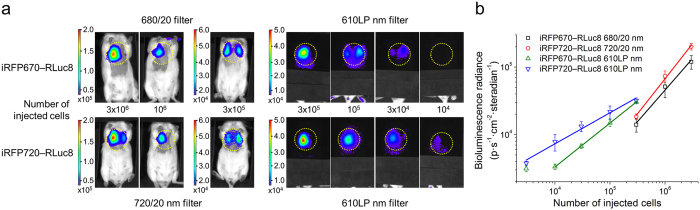
Deep-tissue BLI with NIR chimeric luciferases.(a) Imaging of MTLn3 cells stably expressing iRFP670—RLuc8 or iRFP720—RLuc8 injected in CFW mice via tail vein (ventral view). The color bars indicate the total bioluminescence radiance (photons s−1 cm−2 steradian−1) or the total fluorescence radiant efficiency (photons s−1 cm−2 steradian−1 per μW cm−2). The yellow circles represent regions of interest (ROI) used for data quantification. (b) Values of bioluminescence signal for the images in (A). The blue, green, black and red lines represent linear approximation of dependence of logarithm of the signal strength on logarithm of the number of cells. Error bars, s.d. (n = 5).